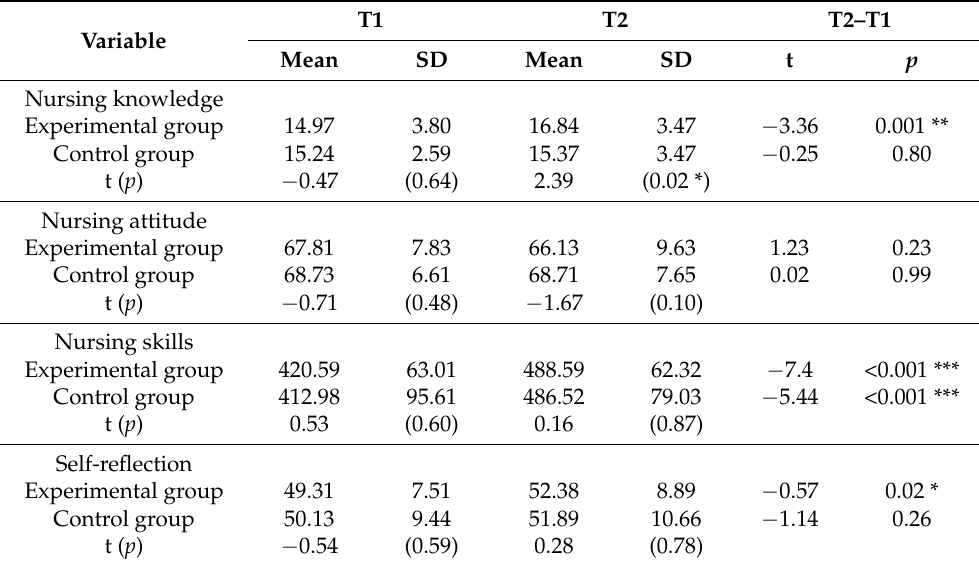
Table 2. Comparison of learning effectiveness before (T1) and after (T2) internship (N =